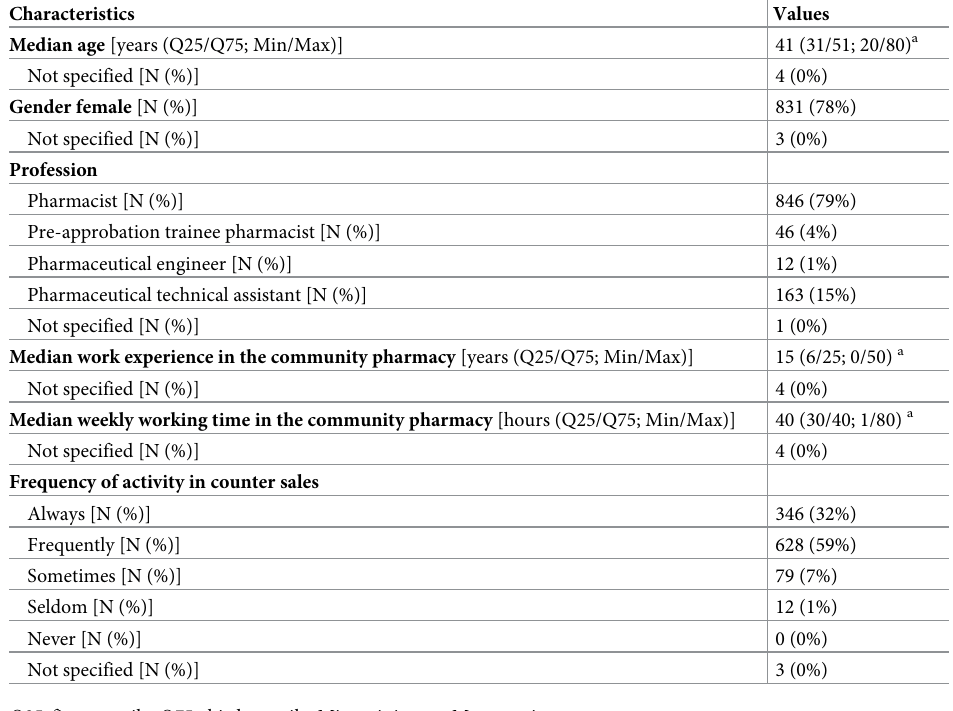
Table 1. Characteristics of participants in the self-report (study part A) [N total = 1068]. Characteristics